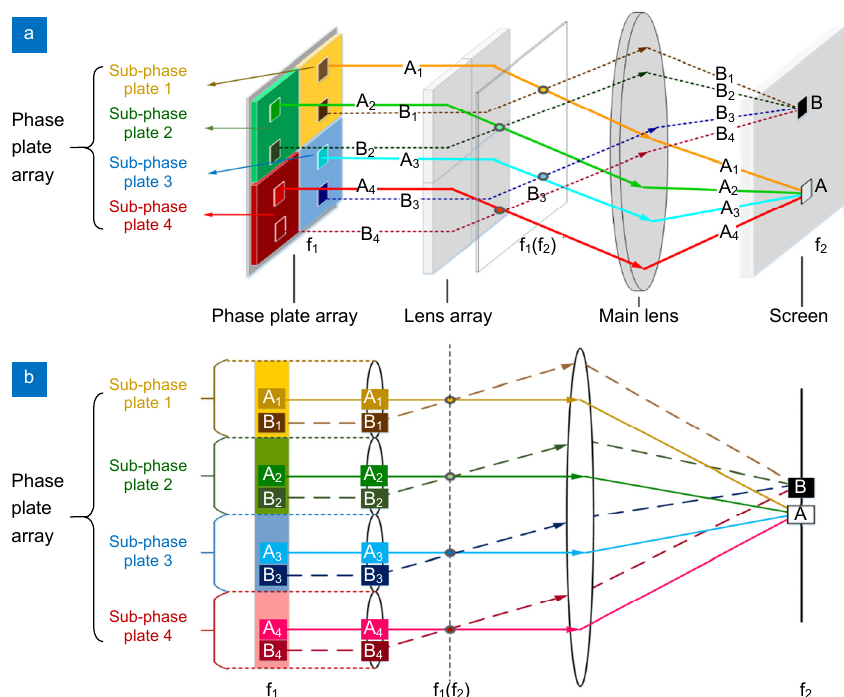
Fig. 4 | ( a ) The incoherent speckles that correspond to different SH should superpose in the same position. Each sub-phase plate should corre- spond to lens unit of LA both in size and position. ( b ) To further understand the stated relationships, the 2×2 PPA is converted into a 1×4 PPA and its side view is given.